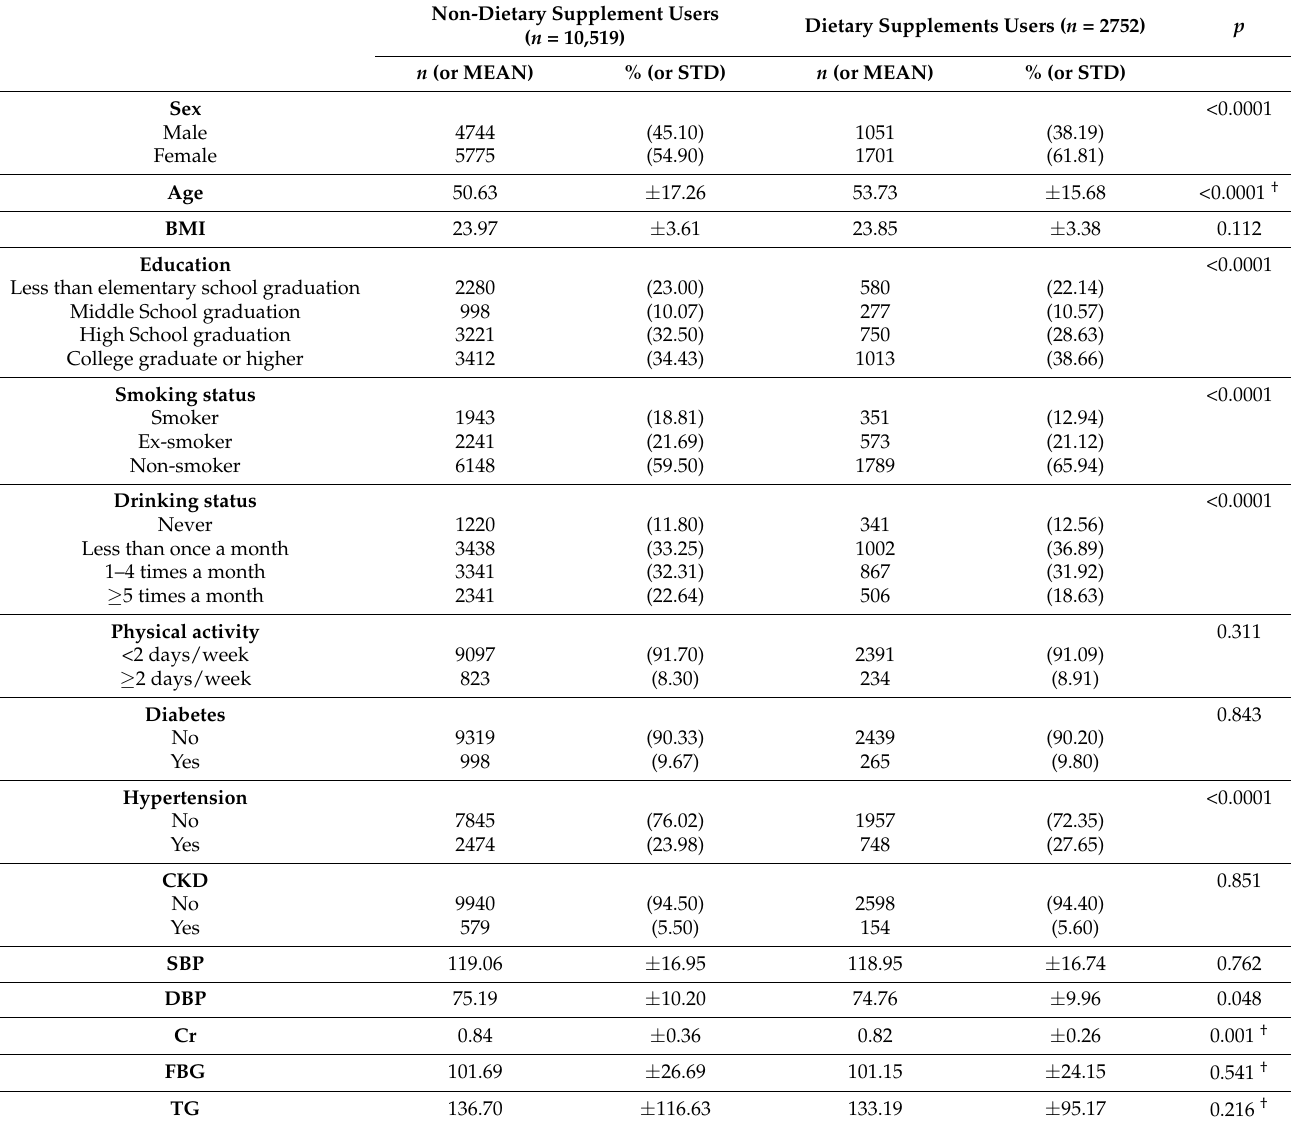
Table 1. General characteristics of participants ( n =